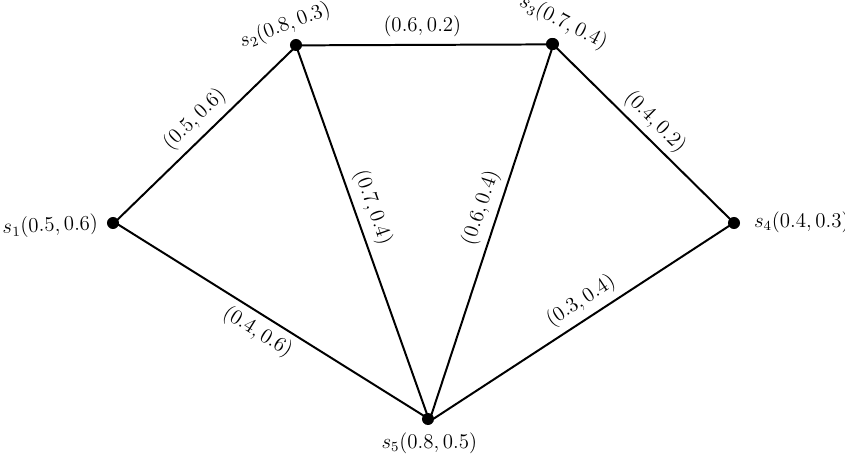
Figure 2. Pythagorean fuzzy Figure 2: Pythagorean fuzzy graph.